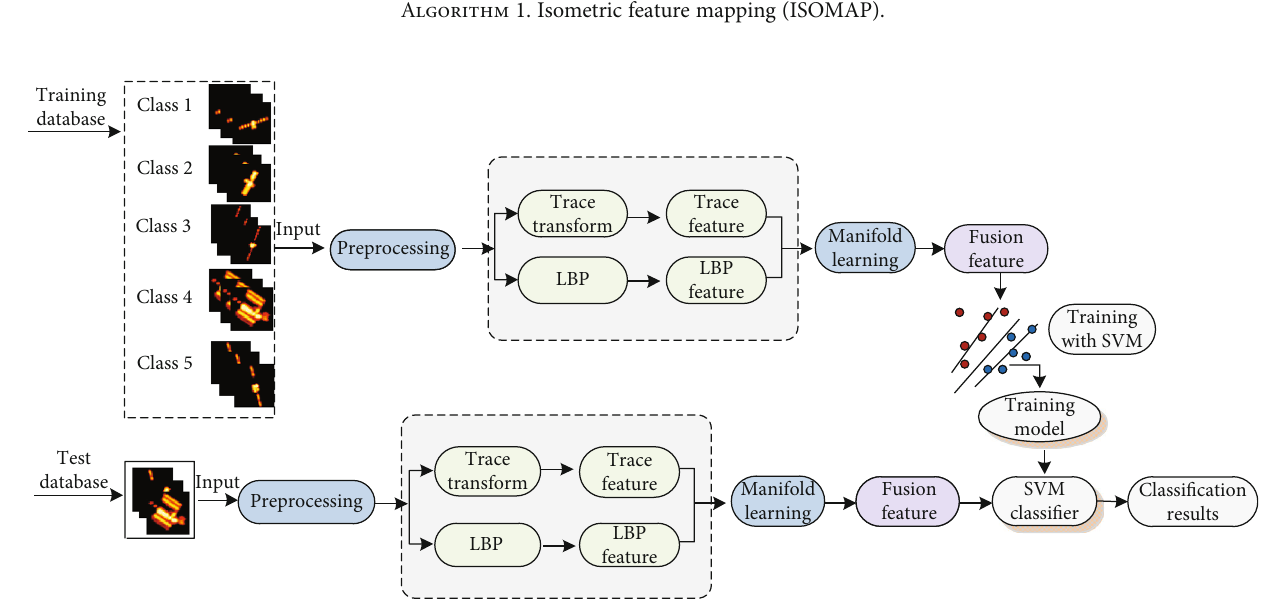
Figure 13: Framework of the classi fi cation algorithm based on the SVM classi fi er.